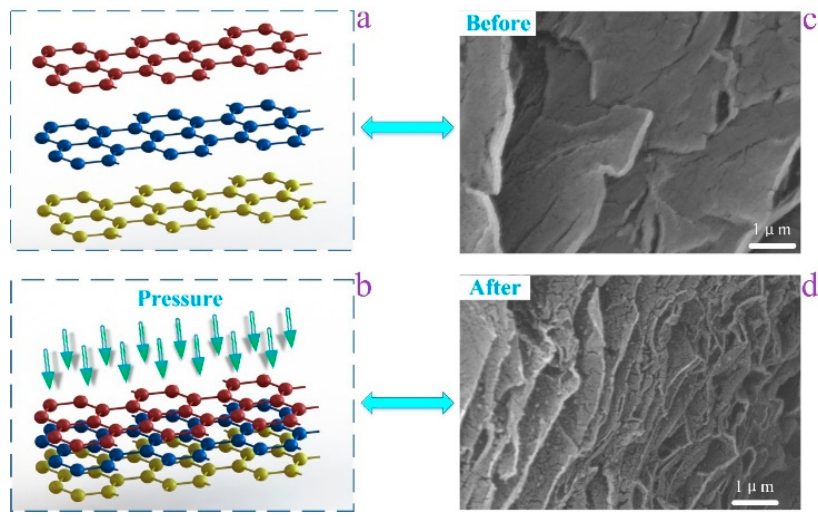
Figure 4. Layered structure model and SEM of r-GO: ( a ) schematic showing the layered structure model before pressure; ( b ) schematic illustrating the layered structure after pressure; ( c ) SEM image of the r-GO before pressure; ( d ) SEM image of the r-GO after pressure.